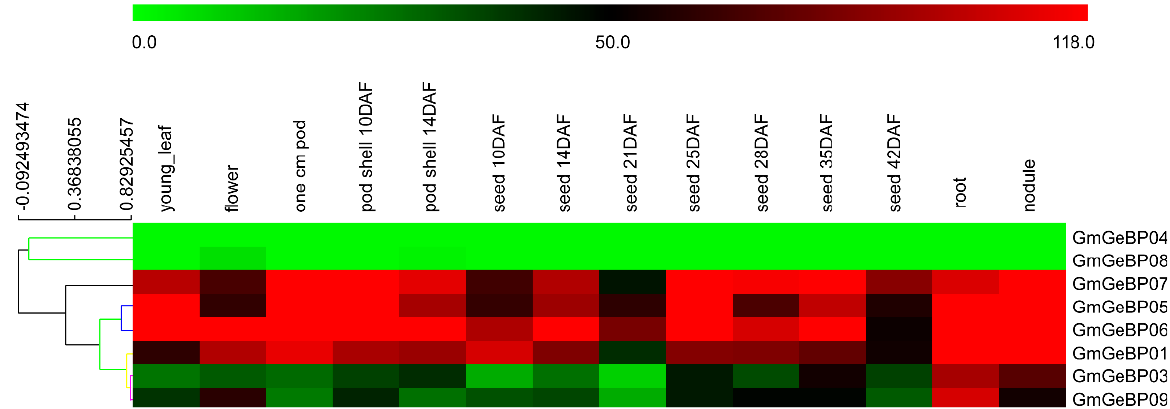
Figure 4. Expression heat map of GmGeBP genes in 14 tissues. RNA-seq relative expression data from 14 tissues were assessed to obtain the expression patterns of soybean genes. The raw data were normalized and retrieved from Soybase.